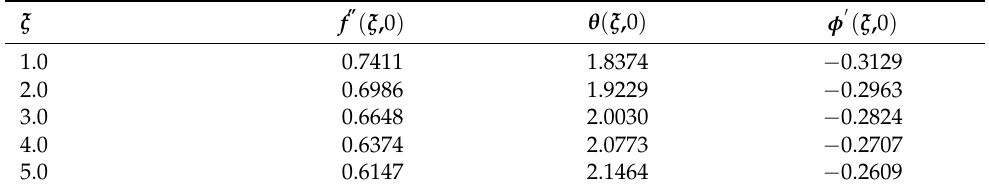
Table 6. Solutions of f (cid:48)(cid:48) ( ξ ,0 ) , θ ( ξ ,0 ) , and φ (cid:48) ( ξ ,0 ) for various values of ξ at n = 1.0, Sc = 1.0, N = 1.0,